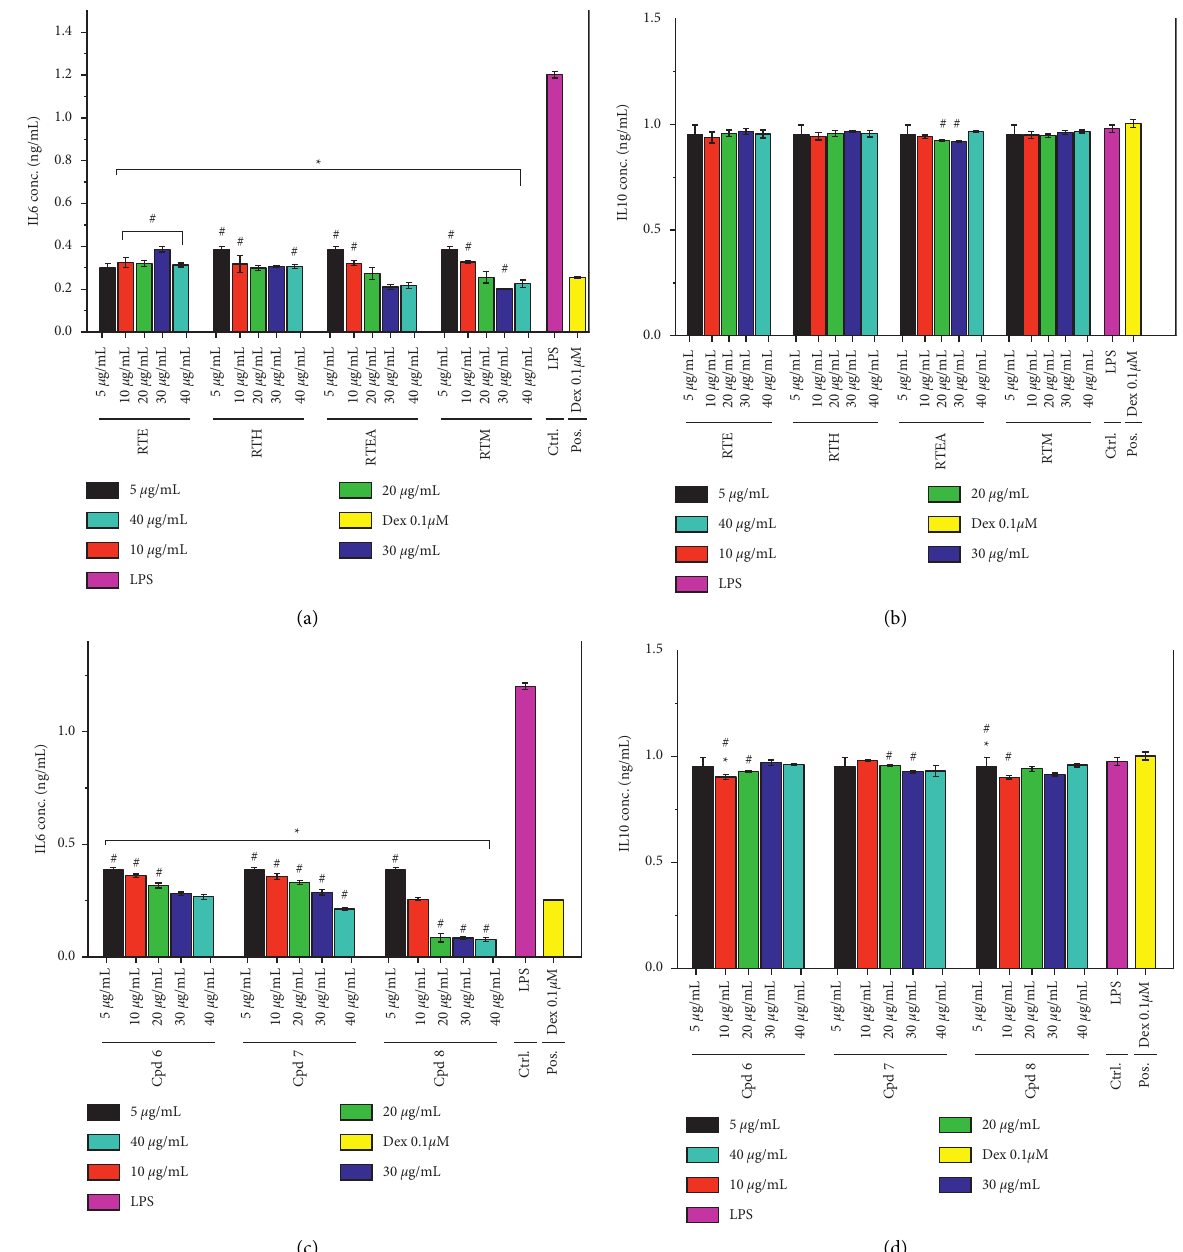
Figure 3: Effects on the secretion of IL-6 and IL-10 of the ( a, b ) extract and ( c, d ) compounds 6 – 8 in LPS-induced RAW 264.7 macrophages. Cells were pretreated for 2 h with indicated concentrations (5, 10, 20, 30, and 40 μ g/mL) and then stimulated with LPS (1 μ g/mL) for another 24h. Data are expressed as mean ± S.D. of three independent experiments. ∗ p < 0.05 versus the LPS group; # p < 0.05 versus the positive group. RTH: (n)-hexane fraction; RTEA: ethyl acetate fraction; RTM: methanol fraction; RTE: crude ethanol